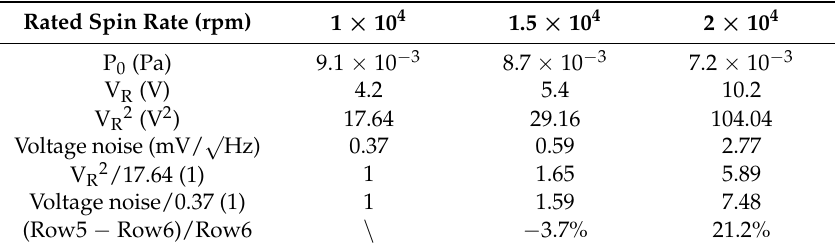
Figure 7. Spectrum analysis of static gyroscope output at different spin rates. Table 2. Analysis of the micromachined electrostatically suspended gyroscope (MESG) output noises and rotation voltages at different spin rates.